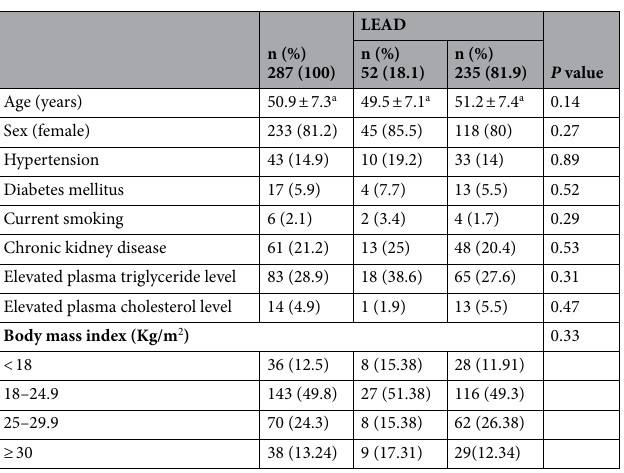
LEAD valuen (%) 52 (18.1)